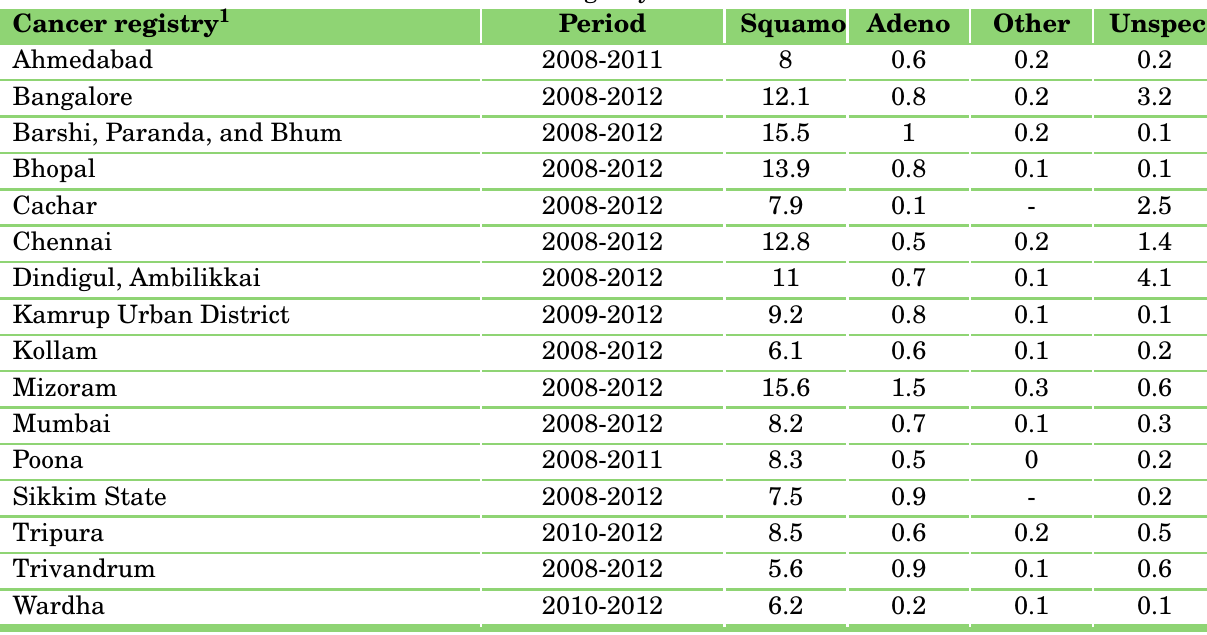
Table 4: Age-standardised incidence rates of cervical cancer in India by histological type and